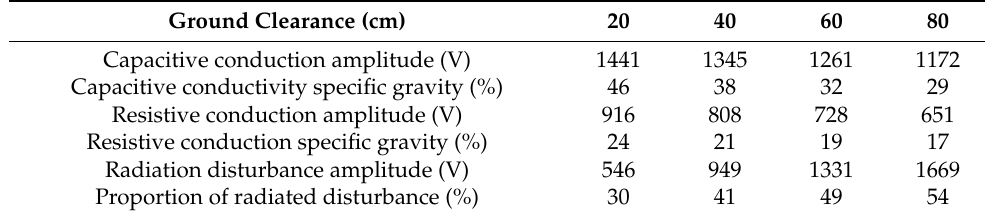
Table 6. Disturbance voltage changes under different cable heights above the